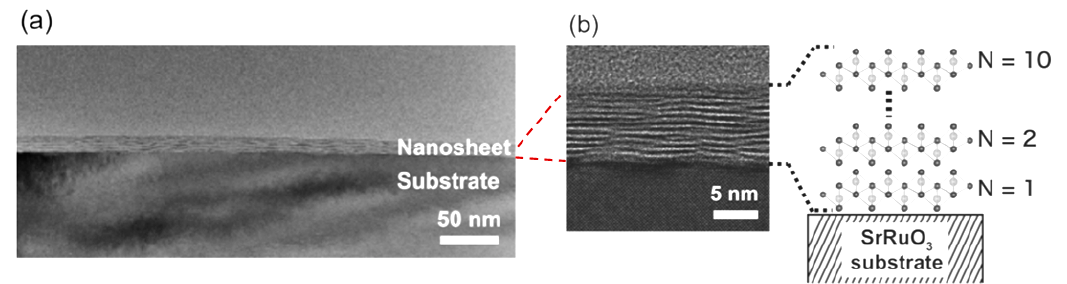
Figure 46. Cross-sectional TEM images of the 10-layer film of Ti 0.87 O 2 nanosheets formed using the LB deposition technique: ( a ) Wide view; ( b ) magnified image. Reproduced with permission from Akatsuka et al. [405]. Copyright 2009: American Chemical Society.